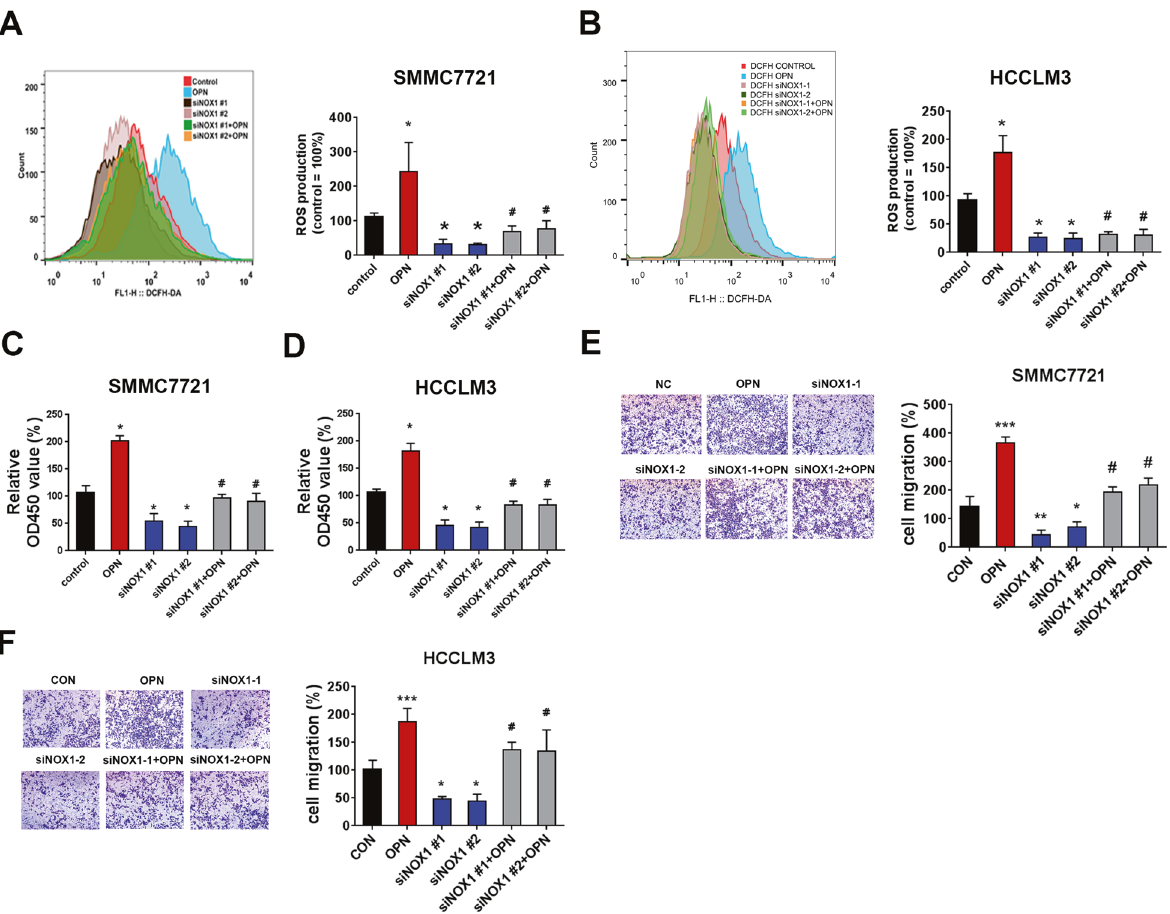
Fig. 3 OPN stimulates ROS production and promotes cell proliferation and migration through upregulating NOX1 in HCC cells. A, B DCFH-DA fl uorescence was used to evaluate total ROS production in control HCC cell, hOPN treated (1 μ g/mL) HCC cells, siNOX1 HCC cells and siNOX1 HCC cells treated with hOPN. Representative images of cell viability ( C ), and cell migration ( E ) assays using SMMC7721 control, hOPN treated, siNOX1 treated, and siNOX1 + OPN treated SMMC7721 cells. All the experimental conditions in ( C , E ) were the same as in D , F , except SMMC7721 cells were used instead of HCCLM3 cells. Original magni fi cation, ×100. Data indicated mean ± SD. n = 3, * P < 0.05, ** P < 0.01, *** P < 0.001, # Compared with hOPN treatment, NS not signi fi